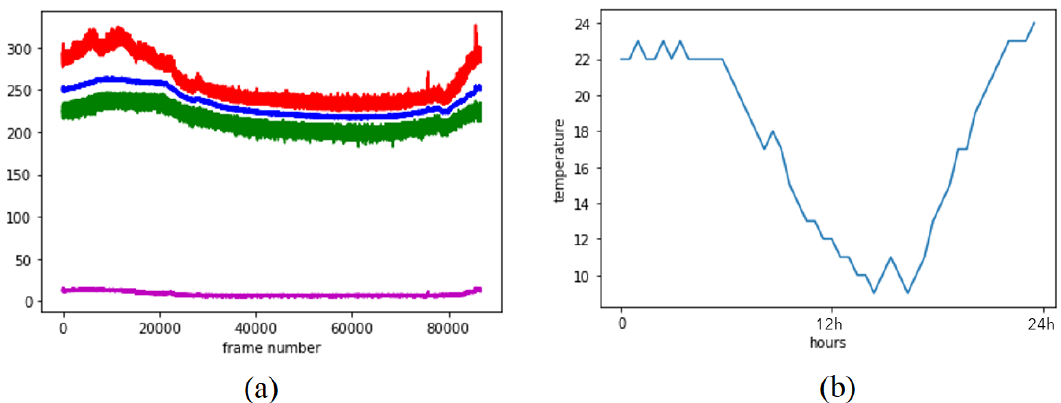
Figure 10. ( a ) Red; f 3 , maximum pixel value of each frame (the maximum value is around 360, which corresponds to 36 degree Celsius). Blue; f 1 mean pixel values. Green; f 2 minimum pixel values. Magenta; f 0 standard deviation of the pixel values in each frame. ( b ) Outside temperature in Malmö, south Sweden, from the beginning to the end of the heat sensor recording used in ( a